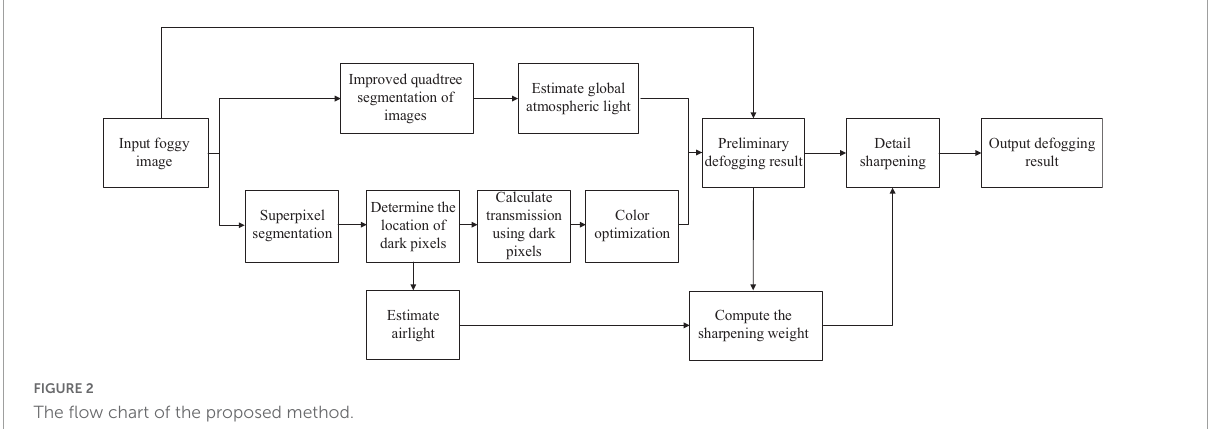
FIGURE2 The flow chart of the proposed